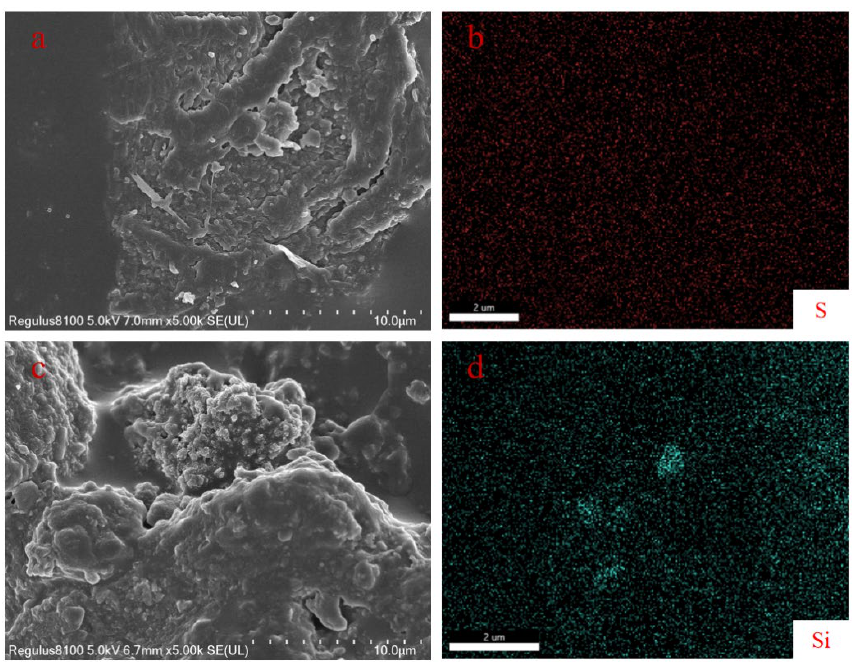
Figure 8. SEM images of PEDOT:PSS/epoxy coating (P:E = 1:4) ( a ) and PEDOT:PSS/epoxy/(KH560/SiO 2 ) coating (P:E:K = 1:4:0.15) ( c ). EDS mapping (S and Si elements) images of PEDOT:PSS/epoxy coating (P:E = 1:4) ( b ) and PEDOT:PSS/epoxy/(KH560/SiO 2 ) coating (P:E:K = 1:4:0.15) ( d ).